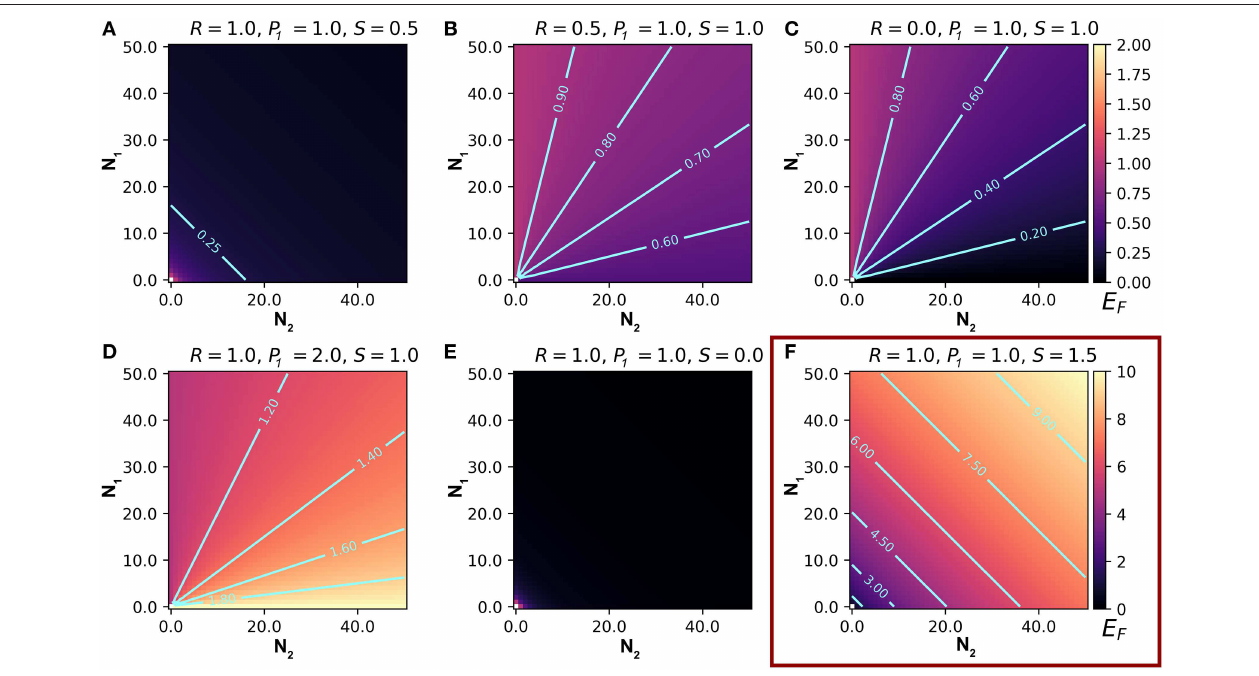
FIGURE 1 | Representative output from a model that predicts the number of eavesdroppers that will attack a focal individual (E F ) of prey type 1, in an aggregation containing varying numbers of type 1 and type 2 signaling prey. Each frame presents predictions based on different values of the relative attractiveness of the two prey types ( R ), the eavesdroppers’ expressed preference for type 1 prey ( P 1 ), and the relationship between the weighted number of prey and the number of eavesdroppers attracted to the aggregation ( S ). (A–E) represent E F on a scale from 0 to 2 (scale bar on upper right), and (F) represents E F on a scale from 0 to 10 (scale bar on lower right). See text for